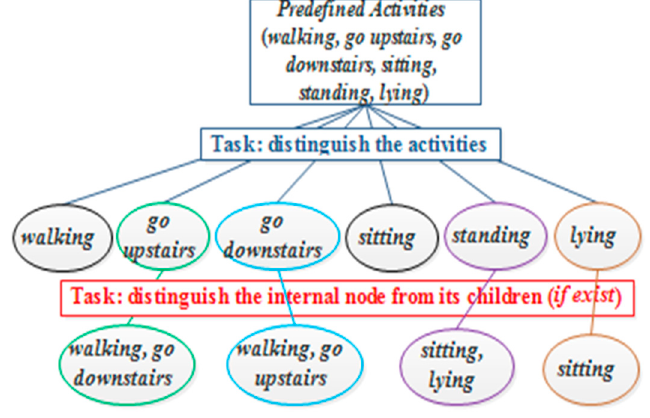
Figure 2. The clustering-guided hierarchical human activity recognizer on UCI-HAR.